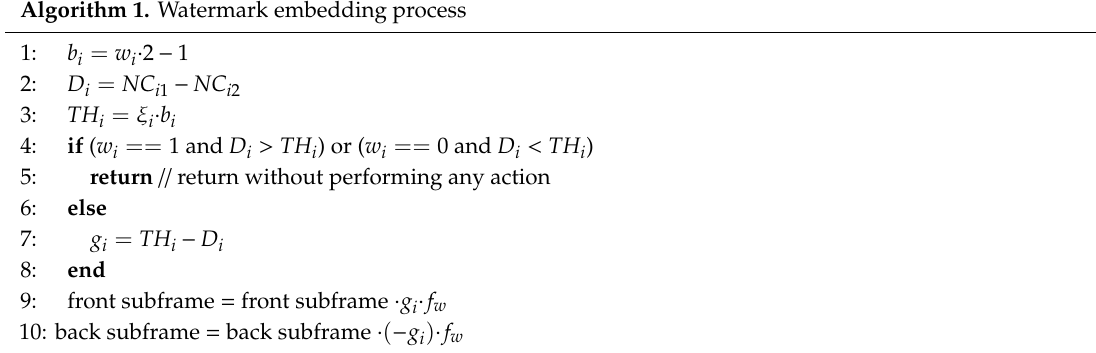
Algorithm 1. Watermark embedding process